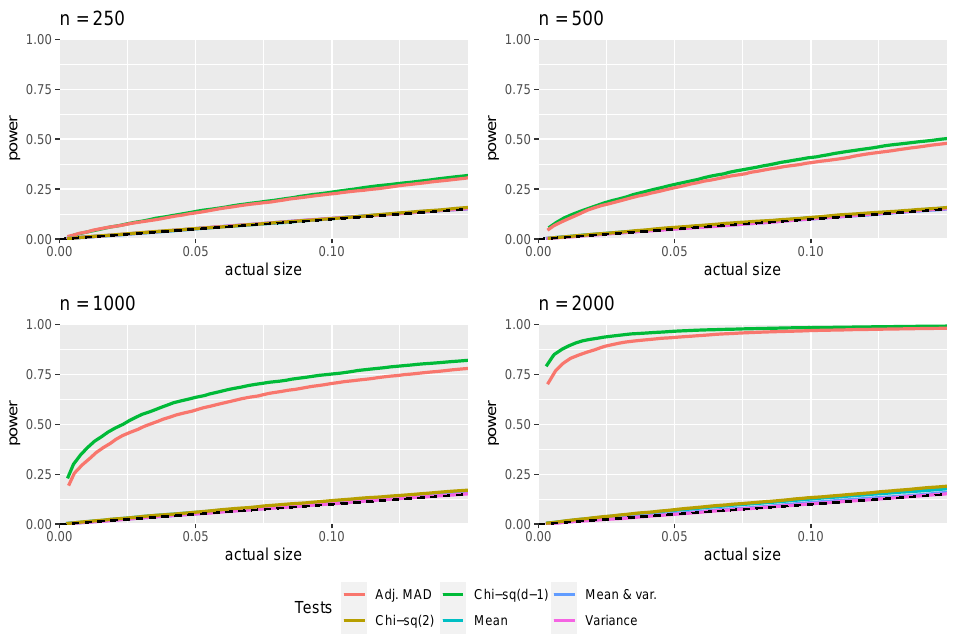
Figure 10. First two digits tests: size–power curves of the tests against the rounding mixing alternative with λ = 0.75. Tests are as follows: “Adj. MAD”, adjusted MAD (10); “Chi-sq(2)”, χ 2 ( 2 ) test on mean and variance (4); “Chi-sq(d-1)”, χ 2 ( 89 ) test (9); “Mean”, normal test on the mean (1); “Mean & var.”, normal test on mean and variance (3); “Variance”, normal test on variance (2). The dashed line is power = actual size . The number of observations is indicated on top of each